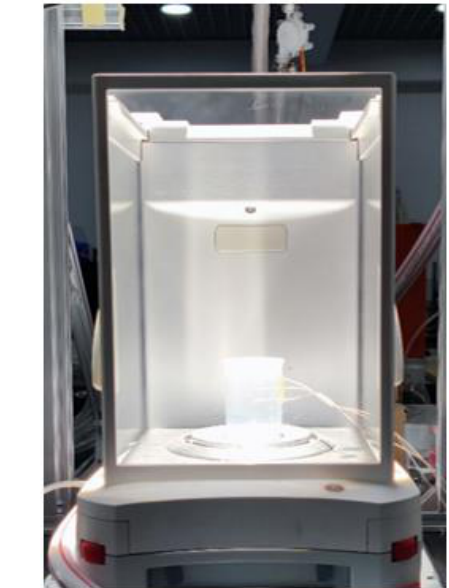
Figure 3. Two-step method for preparing nanofluids.